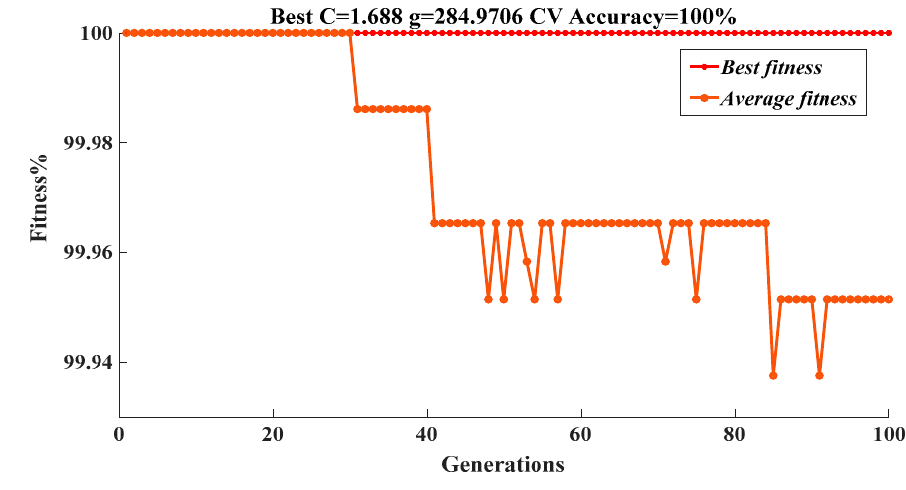
Figure 5. Optimization of parameters by genetic algorithm.